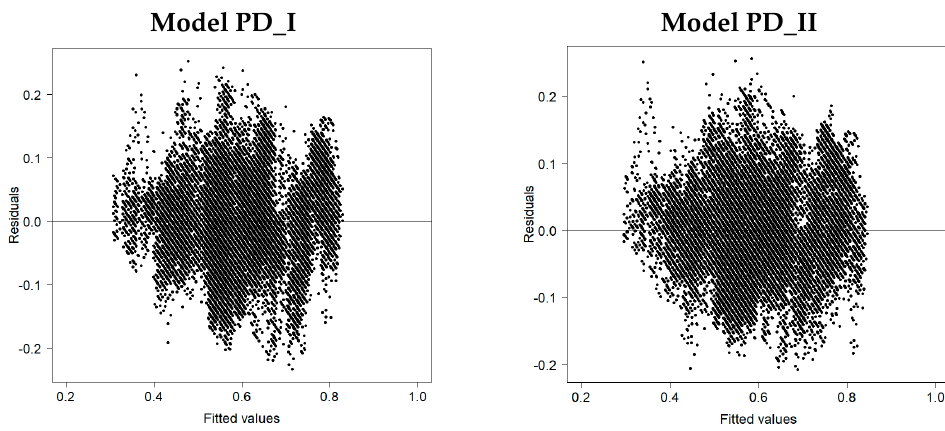
Figure 9. Standardized residuals versus fitted values for Models PD.